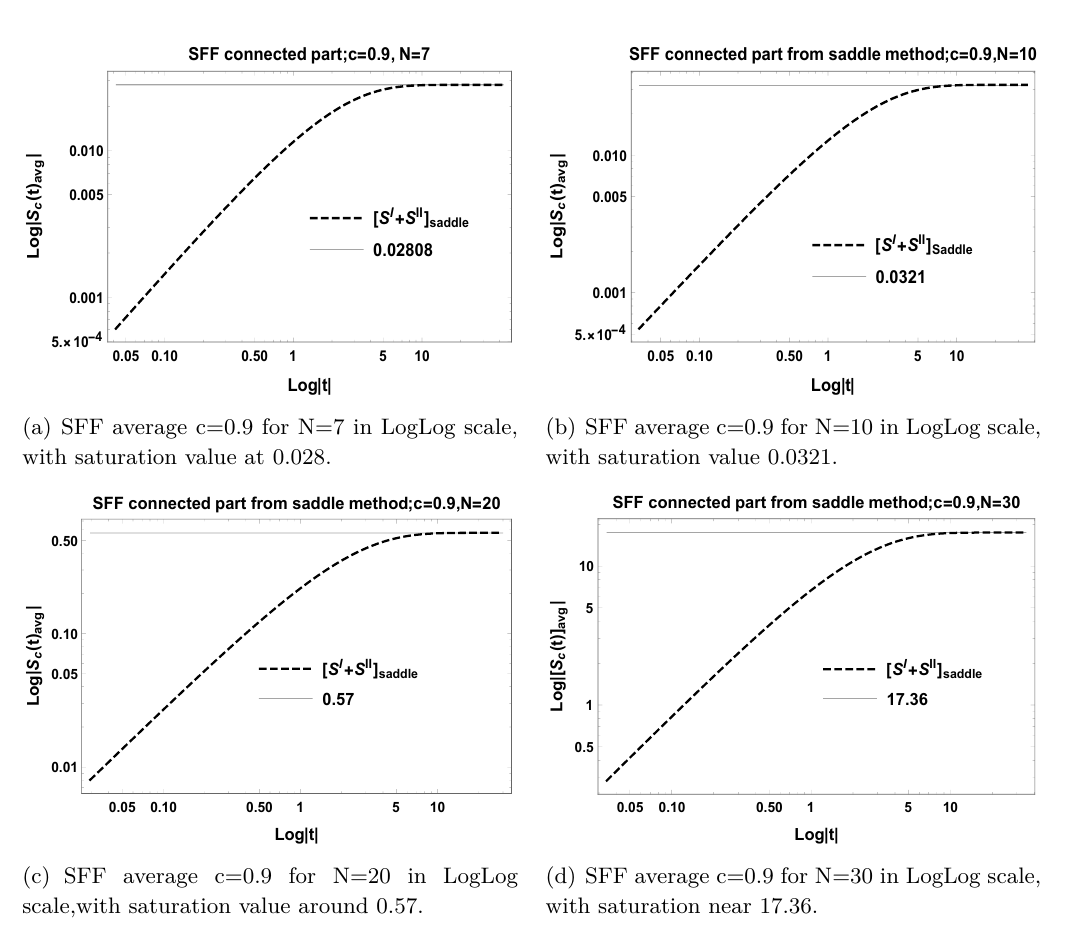
Figure 5 . Spectral Form Factor averaged over an interval [0 , t ] from eq. (2.48) is plotted in Log-Log scale. We have considered both connected and disconnected part in this